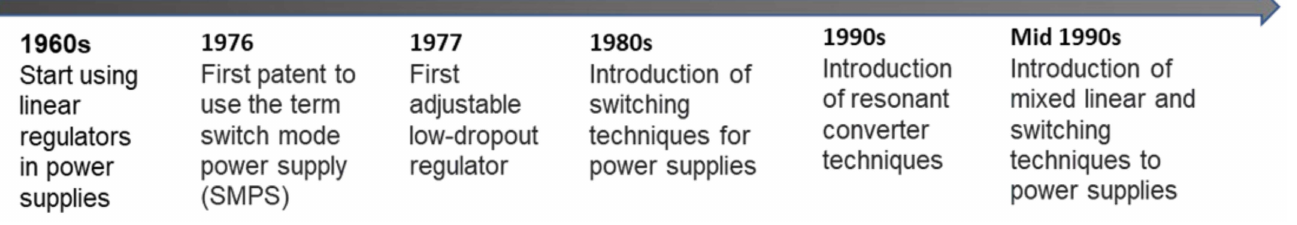
Figure 2. Evolution of power supply design